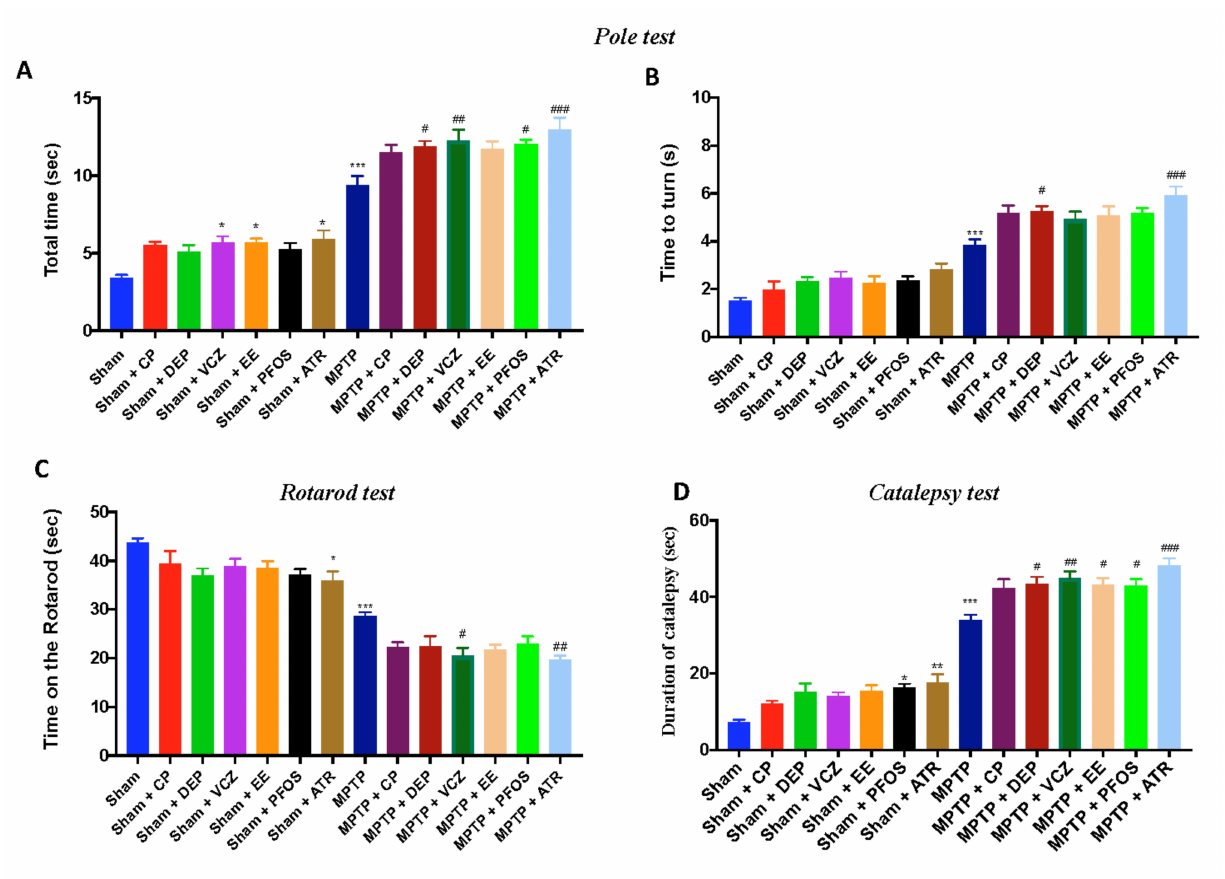
Figure 8. Behavioral analysis motor impairments: Pole test ( A , B ). Rotarod test ( C ). Catalepsy test ( D ). Data are expressed as the mean ± SEM of N = 6 mice/group. * p <0.05 vs. sham; ** p < 0.01 vs. sham; *** p < 0.001 vs. sham; # p < 0.05 vs. MPTP; ## p < 0.01 vs. MPTP; ### p < 0.001 vs.